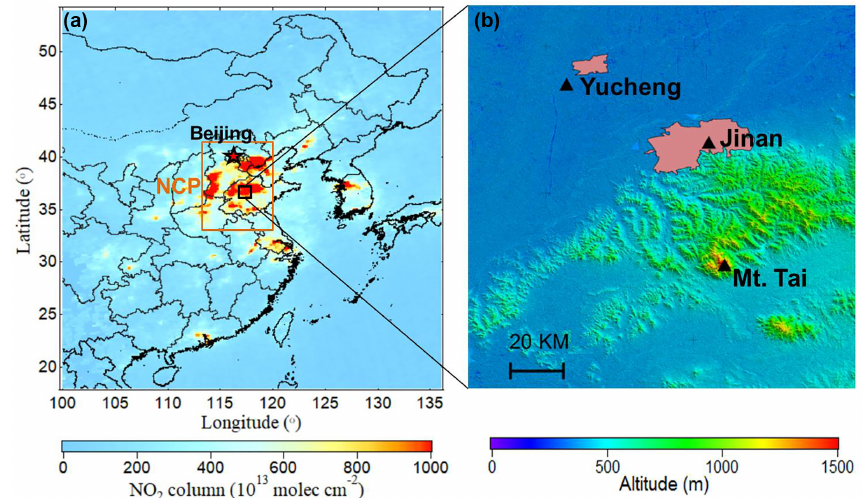
Figure 1. Map showing the study region and three measurement sites. Panel (a) is color coded with the OMI (Ozone Monitoring Instrument)- retrieved tropospheric NO 2 column density in July 2014, and panel (b) is color coded with the topographic height (the pink regions denote urban